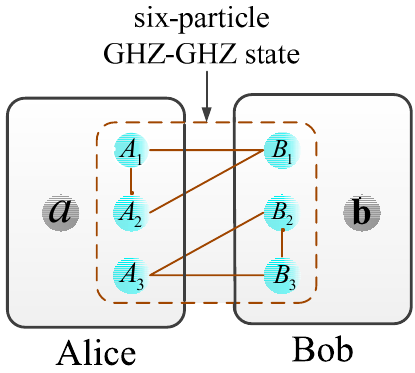
Figure 1. The composite Greenberger–Horne–Zeilinger (GHZ)-GHZ state previously shared between Alice and Bob.